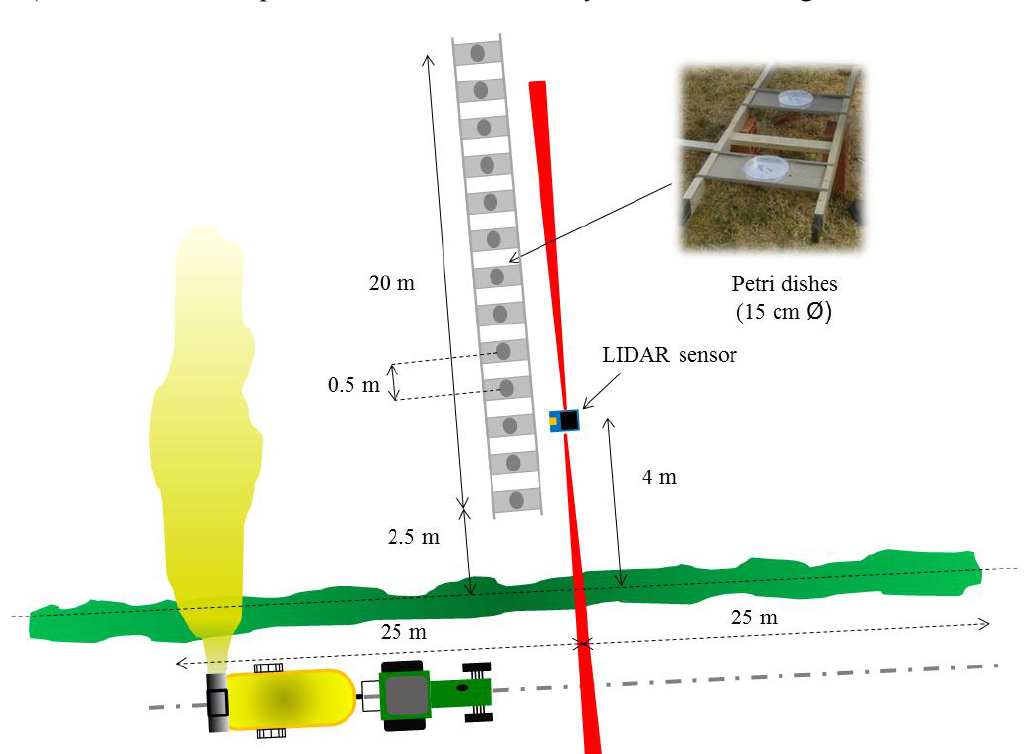
Figure 2. Scheme of placement of drift measurement devices (LIDAR sensor and test bench) related to last crop row and track followed by the tractor during field